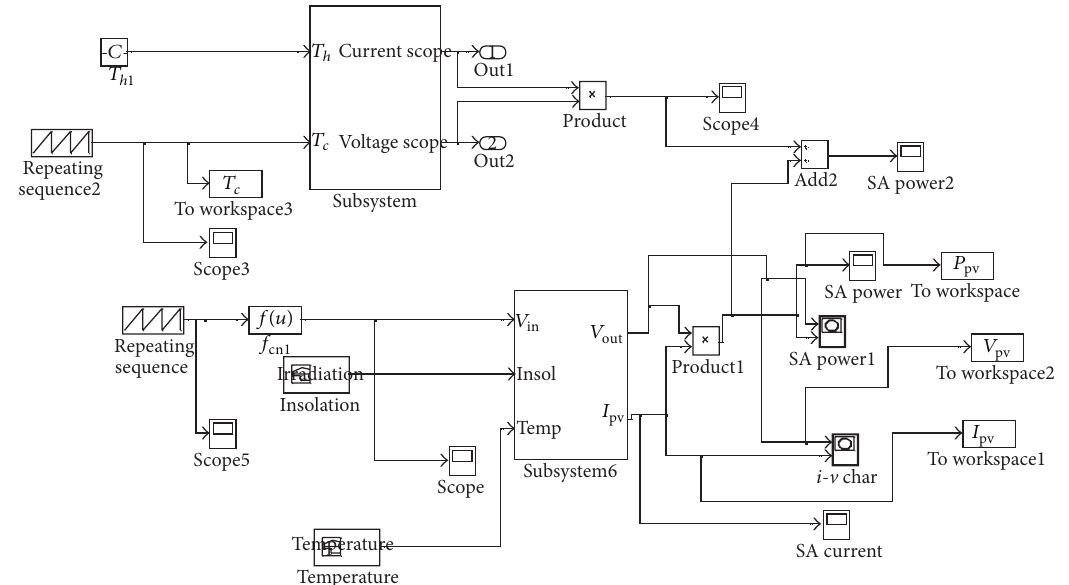
Figure 4: Thermoelectric-solar hybrid energy system block model applied in MATLAB.